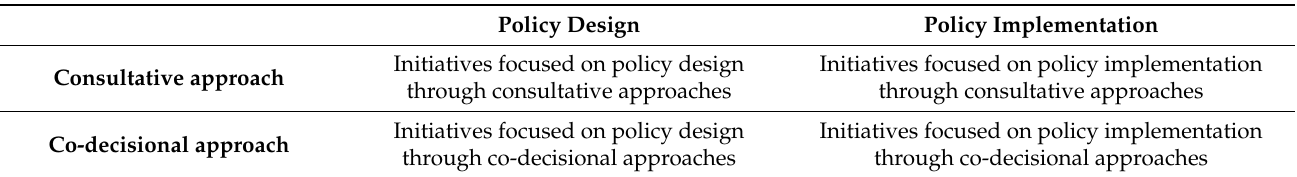
Table 1. Types of senior citizens’ participatory initiatives in policy-making according to the two coordinates on participatory approaches and policy stages. Policy Design Policy